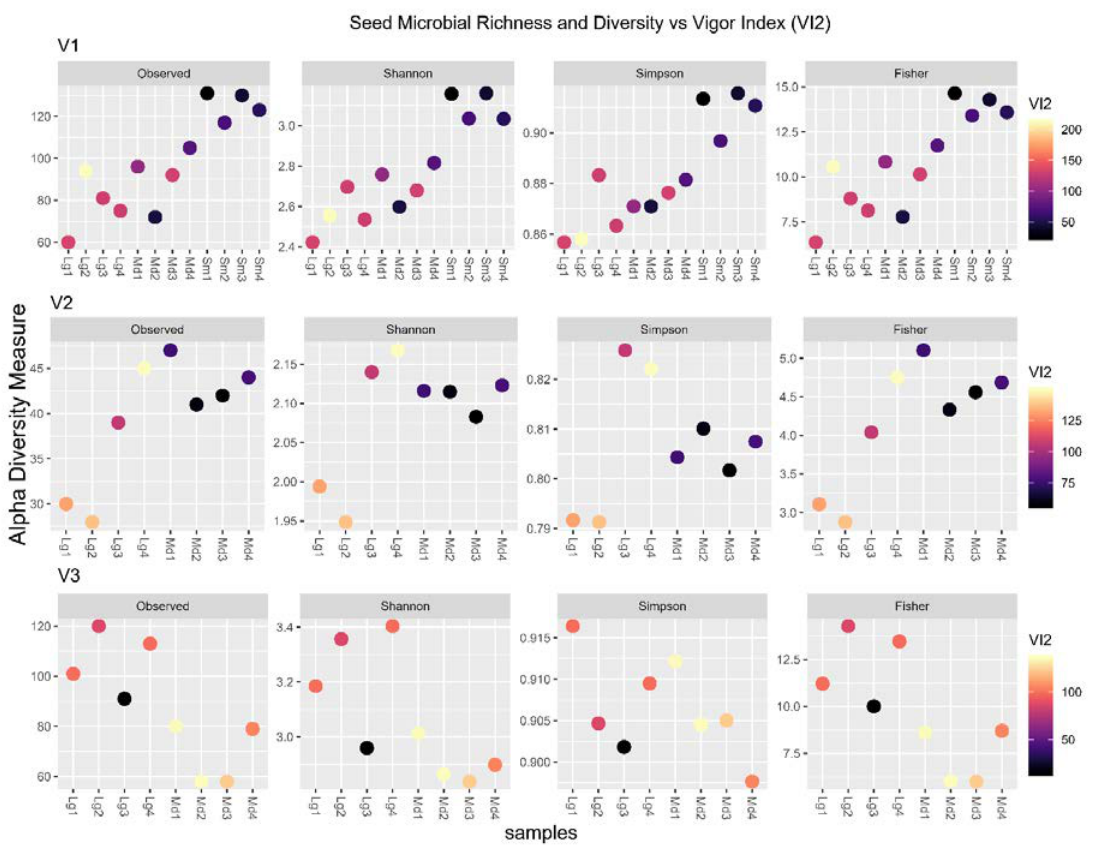
Figure 6. Seed microbial diversity and richness indices of different seed sizes in Varieties 1, 2, and 3; points are colored by Vigor Index-2. Sm1-4, Md1-4, and Lg1-4 are TRF replicates of Small, Medium, and Large size seeds, respectively.